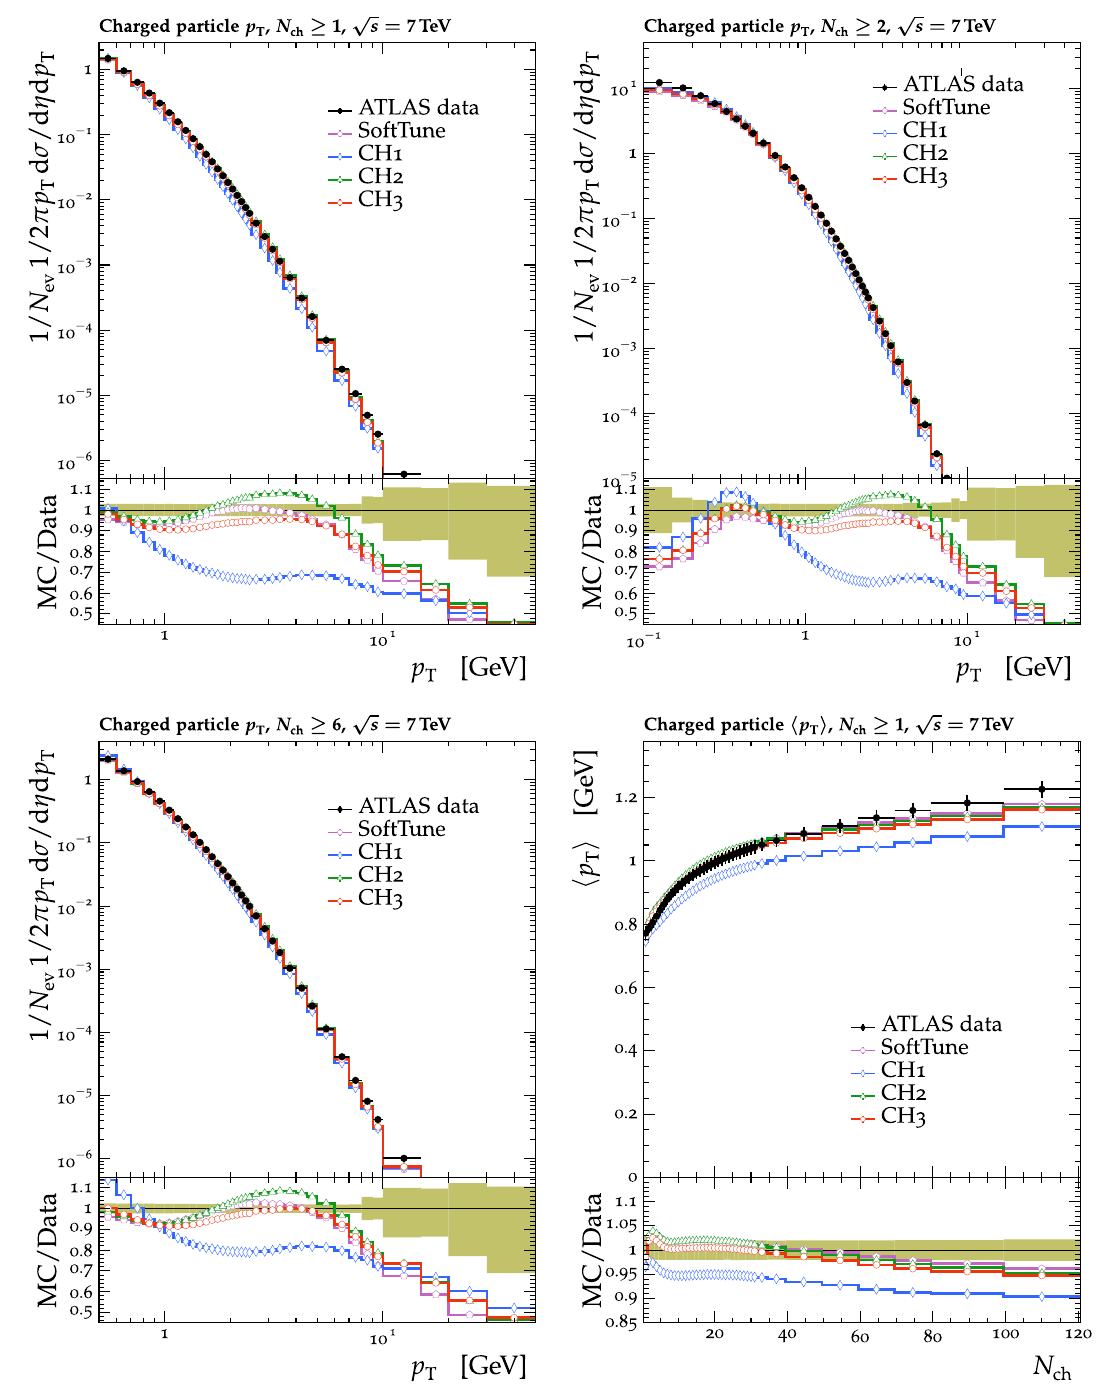
Fig. 23 Normalized plots [17] for the charged-particle p T for N ch ≥ 1 (upper left), N ch ≥ 2 (upper right), and N ch ≥ 6 (lower left). The mean charged-particle p T as a function of the charged-particle multiplicity is also shown (lower right). ATLAS MB data are compared with the pre-